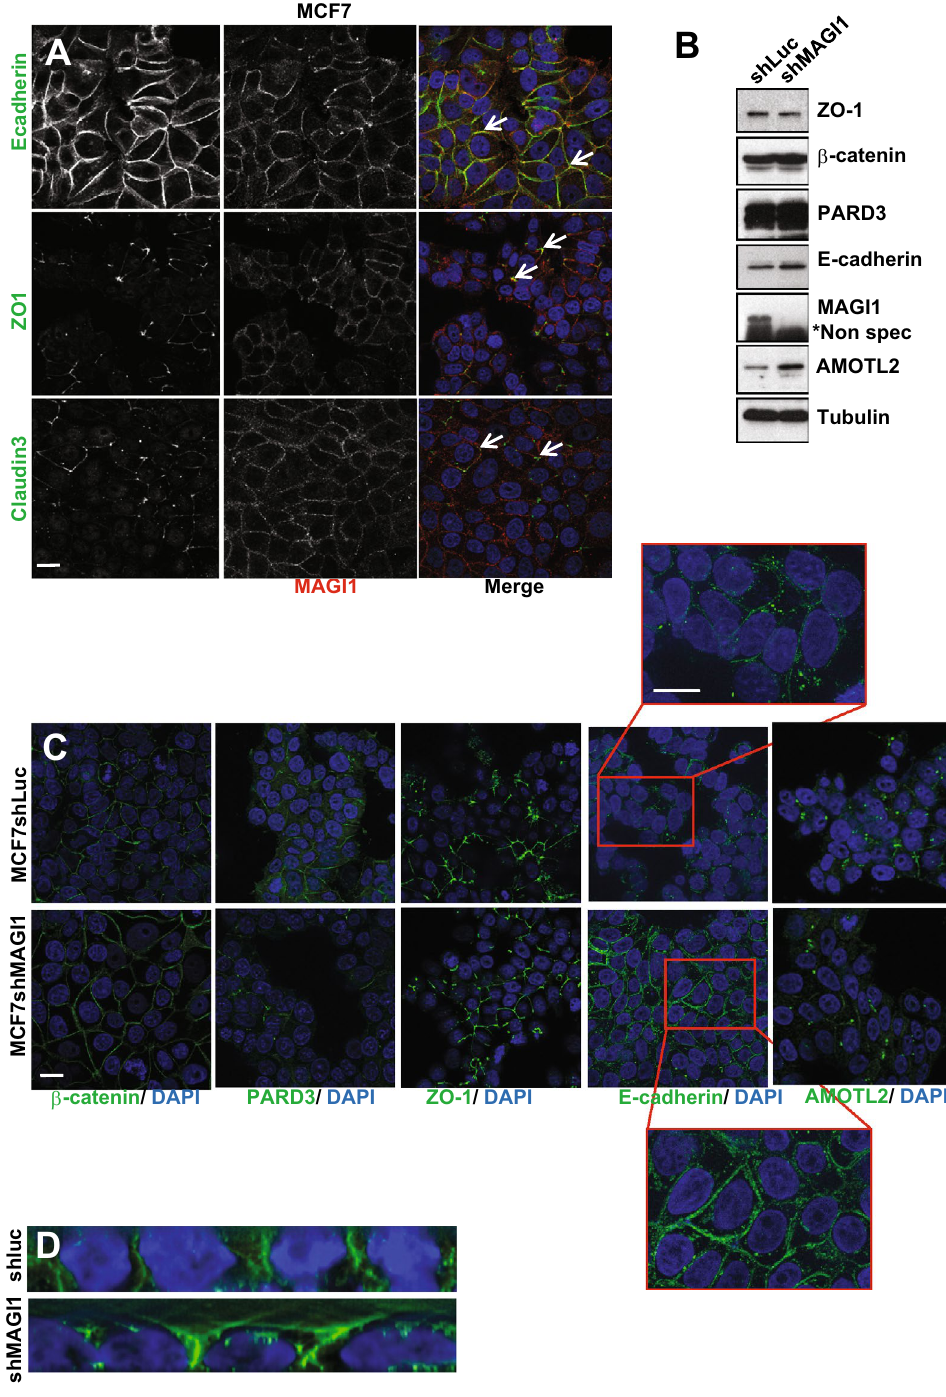
Figure 3. The loss of MAGI1 affects E-cadherin levels and localization in MCF7 cells. ( A ) Representative immunofluorescence experiments performed in MCF7 cells monitoring MAGI1 localization (red) compared to E-cadherin, ZO1, and Claudin3 (green). DAPI (blue) was used to stain DNA and the nuclei. White arrows indicate staining overlap. Scale bar = 10 µm. ( B ) Western blot analysis of whole protein extracts (n = 4) monitoring the expression the junctional components Claudin-1, ZO-1, β-catenin, PARD3, E-cadherin and AMOTL2 in MCF7 shMAGI1 cell lines compared to MCF7 shLuc . Tubulin was used as a loading control. Note the increase in E-cadherin levels. Western blot experiments have been repeated at least four times. Protein expression levels were quantified as compared to Tubulin. Uncropped blots can be found in the Supplementary Information. ( C ) Representative immunofluorescence experiments (n = 3) were performed on MCF7 shMAGI1 compared to MCF7 shLuc cells monitoring the localization of β-catenin, PARD3, Claudin-3, ZO-1 and E-cadherin and AMOTL2 (green). DAPI (blue) was used to stain DNA and the nuclei. Scale bar = 10 µm. Note the slight sub-cortical accumulation of E-cadherin shown in the high magnification images. ( D ) Representative E-cadherin staining (green) of MCF7 shLuc and MCF7 shMAGI1 shown through the Z axis. DAPI (blue) was used to stain DNA and the